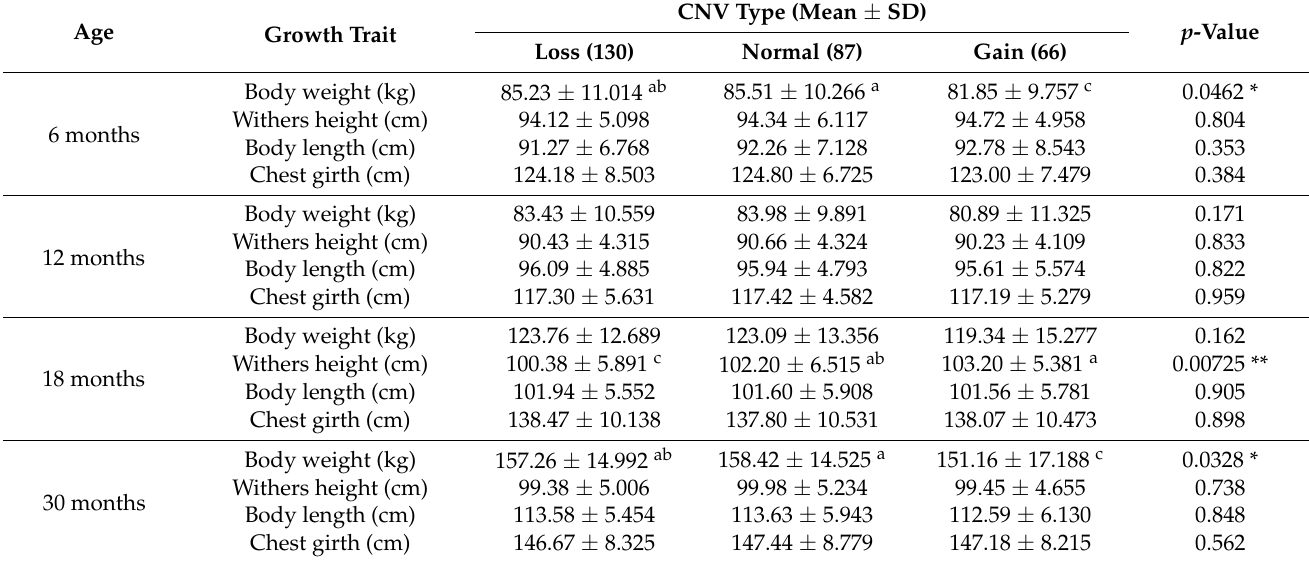
Table 3. Correlations between MOGAT2 CNVs and Ashidan yak growth